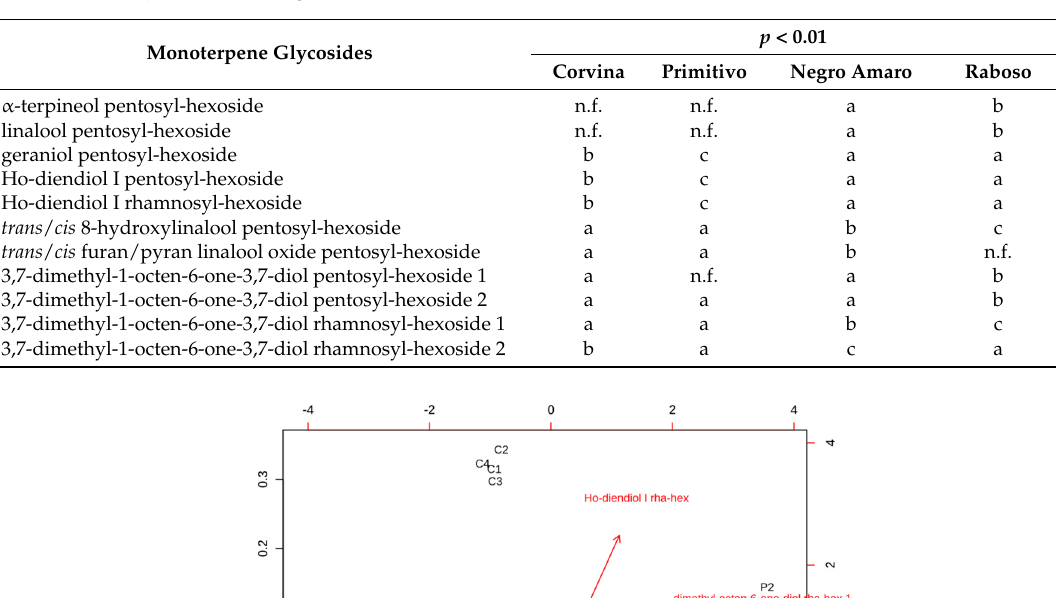
Table 4. Tukey’s test calculated using the normalized UHPLC-Q/TOF signal intensities of monoterpene glycosides identified in the four grape varieties ( n = 4). The data with different letters are significantly different for p < 0.01. n.f., signal not found.